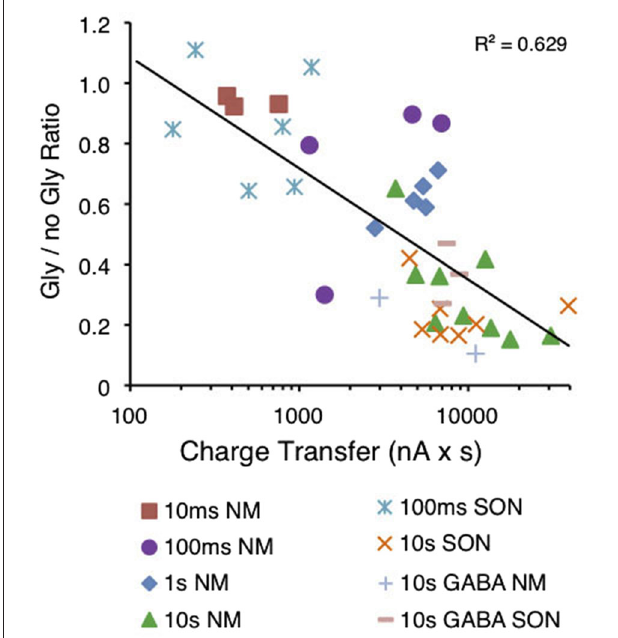
FIGURE 6 | Magnitude of suppression is correlated to the amount of charge transferred during puff application of glycine. Graph depicting the normalized amplitude of the evoked IPSC (gly/no gly ratio) in relation to the amount of charge transferred in response to the glycine pre-application. A significant correlation was observed between the log of the charge transfer and suppression ( R 2 = 0.629, p < 0.0001, n = 40).